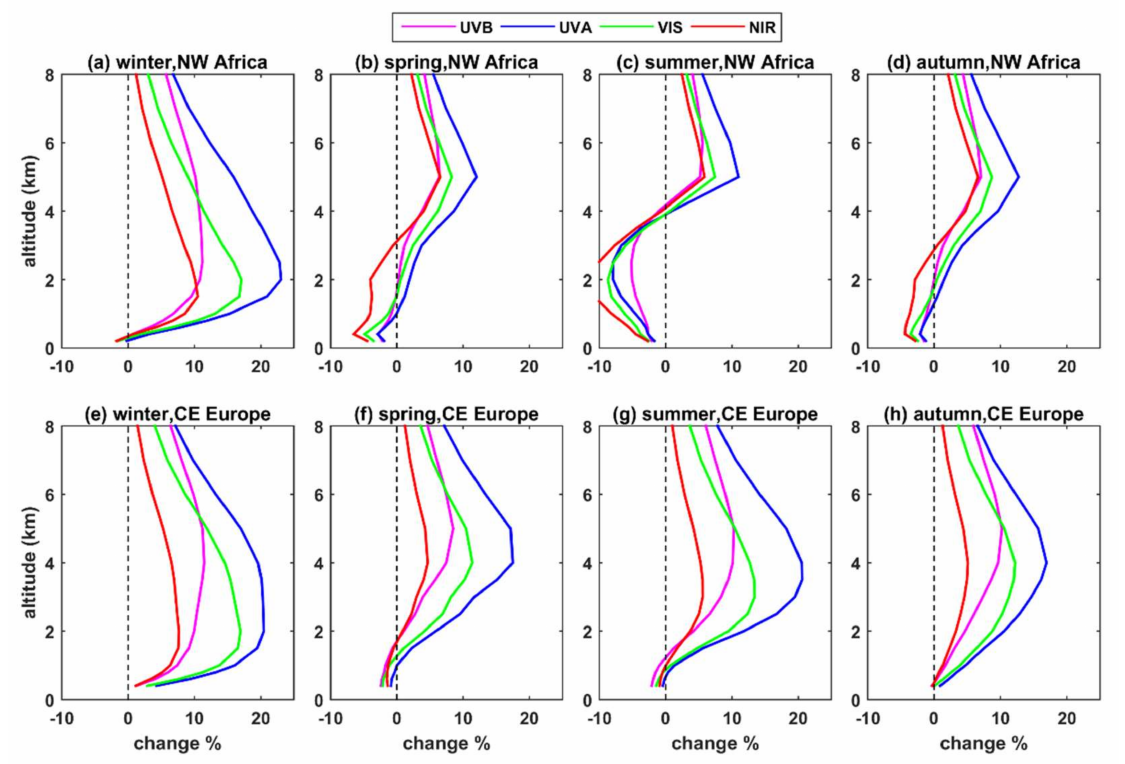
Figure A13. Same as Figure 9, but for SZA = 80 ◦ instead of SZA = 60 ◦